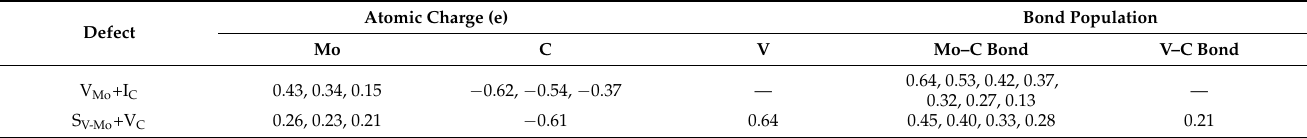
Figure 5. Structure evolution of Mo 2 C supercell with V Mo +I C (I) during optimization process. Cyan and grey balls represent the Mo and C atoms respectively; grey arrows refer to the defect atom. Table 3. Mulliken atomic charge and bond population in the supercell with different defect complexes. In perfect Mo 2 C structure, atomic charge for Mo and C atom is 0.3 and − 0.6, respectively, and all Mo–C bond populations are 0.33. Note: the numbers in the table may vary by ± 0.2.